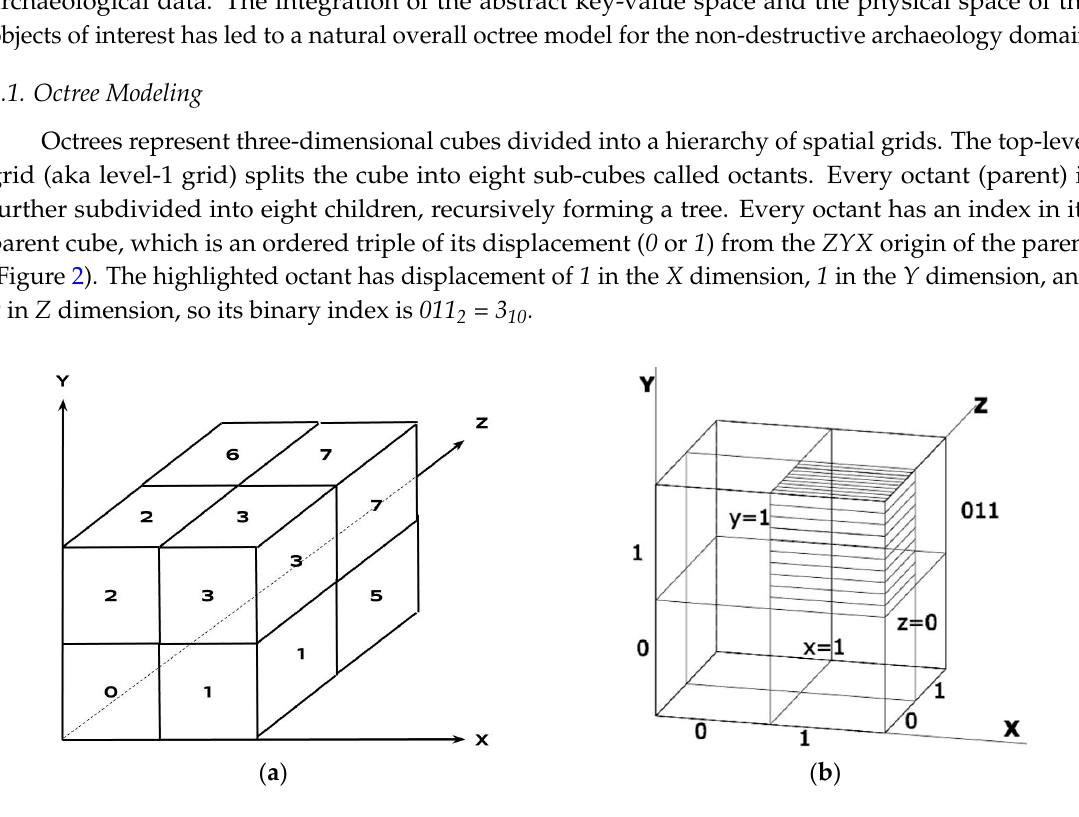
Figure 2. Identifiers of the octree octants. ( a ) Top-level grid split into 8 octants; ( b ) Octant with displacement z = 0 , y = 1 , x = 1 and corresponding index 011 2 .